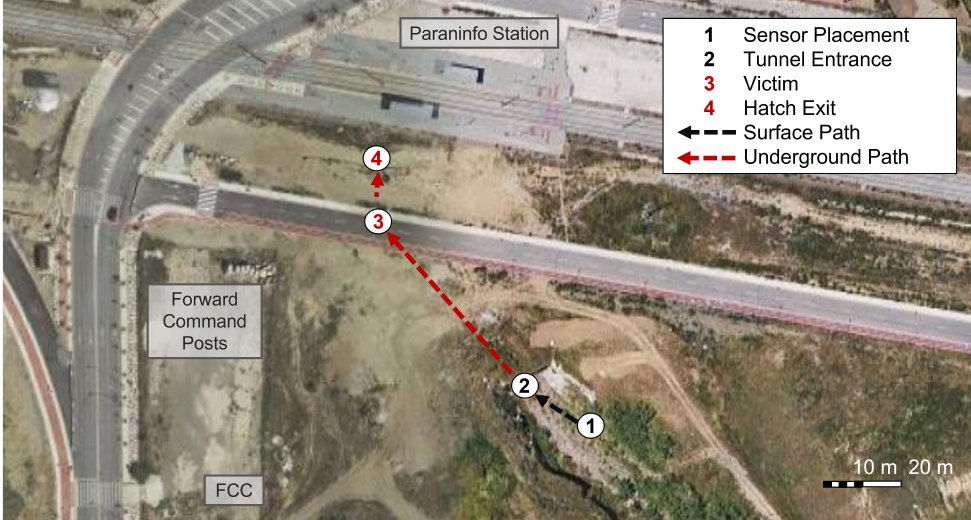
Figure 7. Aerial view [48] of Zone 1. Surface operations in black; underground operations in